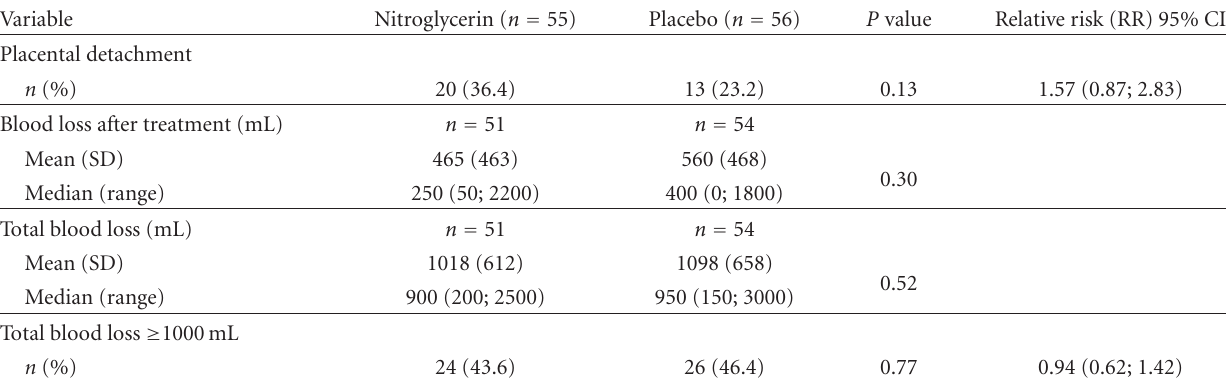
Table 2: Clinical data for management of retained placenta by treatment group (ITT).